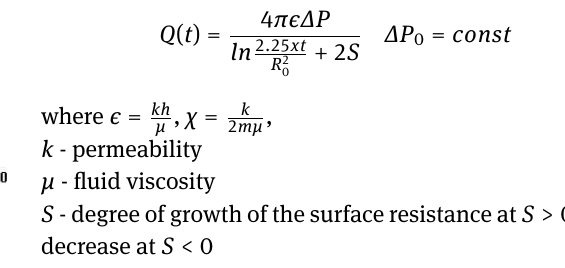
Figure 6: Pressure distribution ( p 0